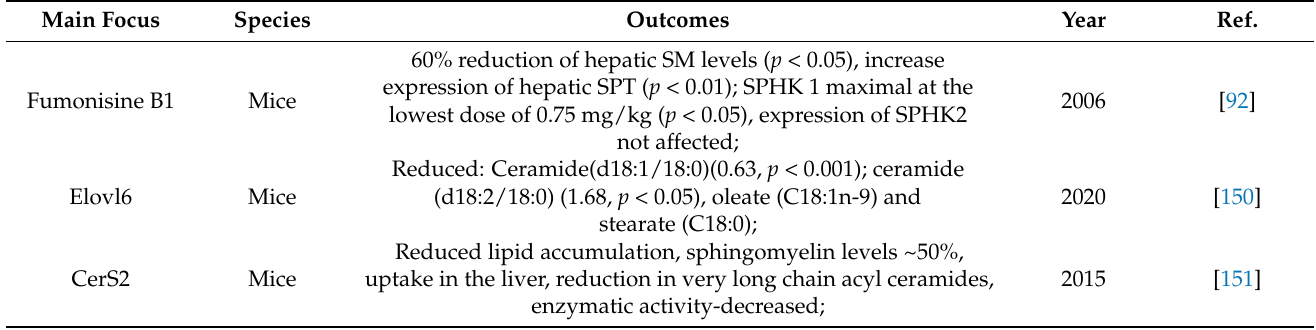
Table 2. Deletion of specific genes, enzymes or supplementation with a specific diet helps to decrease the concentration of ceramides. sphingomyelin (SM); sphingosine kinase 1 (SPHK1); sphingosine kinase 2 (SPHK2); ceramide synthase 2 (CerS2); ceramide synthase 5 (CerS5); ceramide synthase 6 (CerS6); fruit and vegetables (FRUVED); low refined carbohydrates (LRC); ceramide (Cer); triglycerides (TG); alanine-aminotransferase (ALT); aspartate transaminase (AST); dihydroceramide desaturase (DES); Adenosine 5’-triphosphate (ATP); control group (Ctrl); fatty acid elongase 6 (Elovl6); ceramide synthase 1 (CERS1); carnitine palmitoyltransferase 1A (CPT1A); carnitine palmitoyltransferase (CPT2); serine